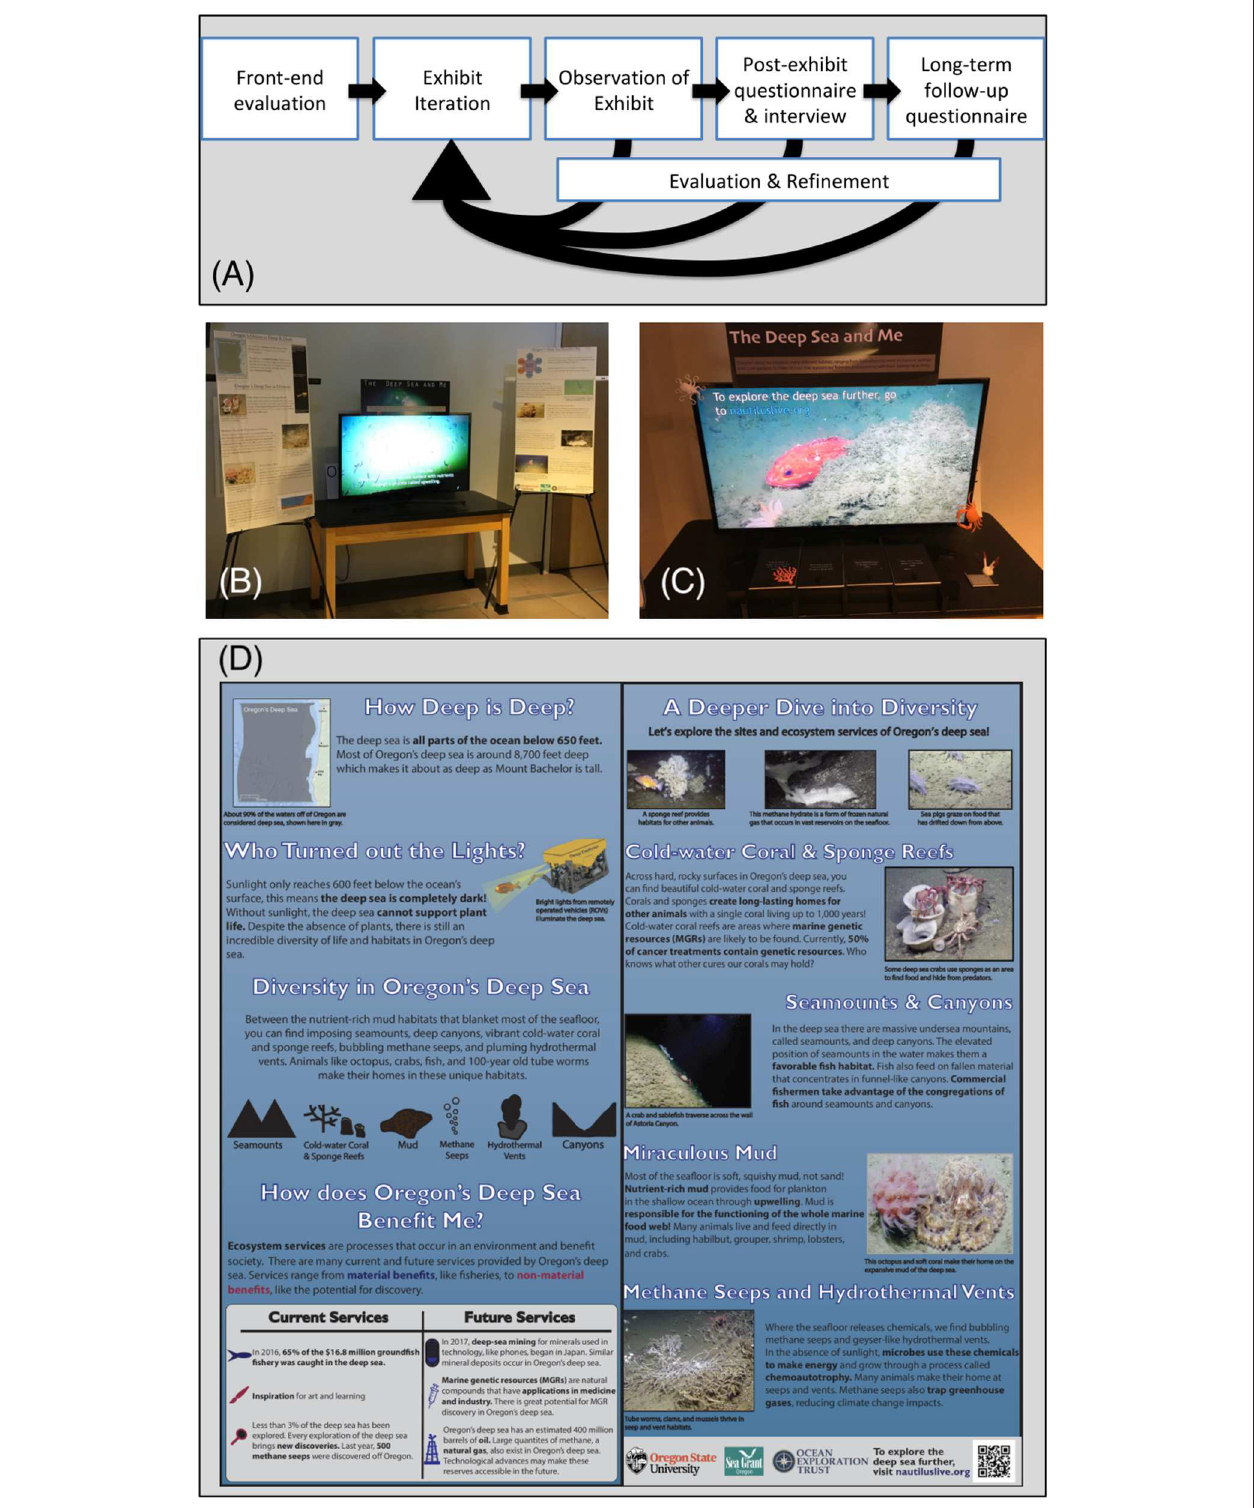
FIGURE 1 | (A) Iterative design-based research framework for the development, evaluation, and refinement of the exhibit. (B) Exhibit iteration A (C) 3D printed deep-sea animals on exhibit iteration C flip-up display, monitor, and table (D) Iteration B and C panels.